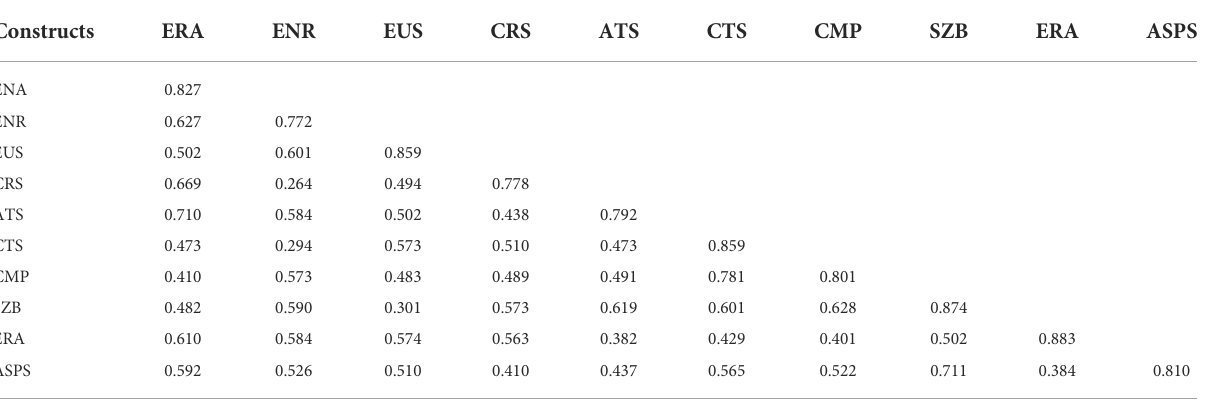
TABLE 2 Results of discriminant validity.